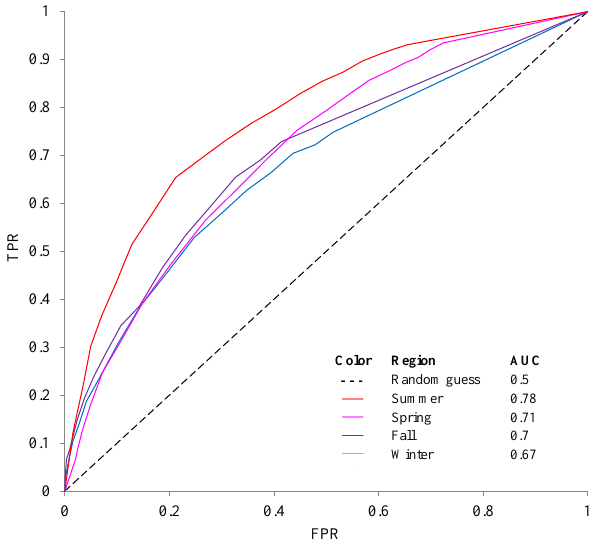
Figure 7. A seasonal evaluation of RFPI predictive skills (vs. the USGS-reported floods) for the Mississippi river